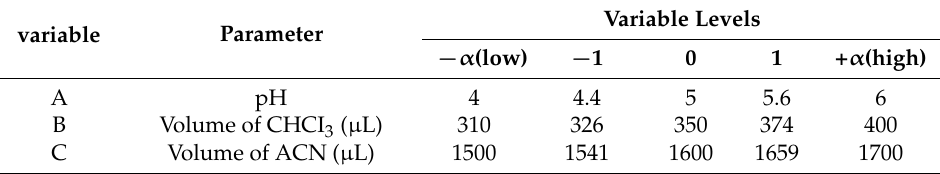
Table 2. The experimental range and levels of the variables in the central composite design